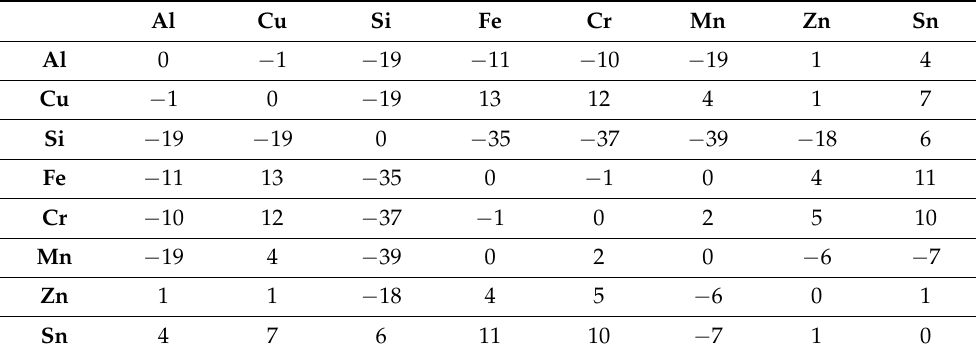
Table 3. Enthalpy of mixing of binary pairs ( i , j ) of individual elements (kJ/mol) of the constituent binary equiatomic HEAs [48].